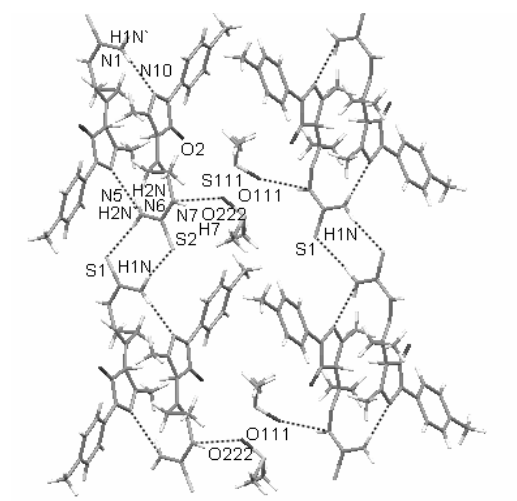
Figure 3. Packing of PropPTMP-ths forming cavity